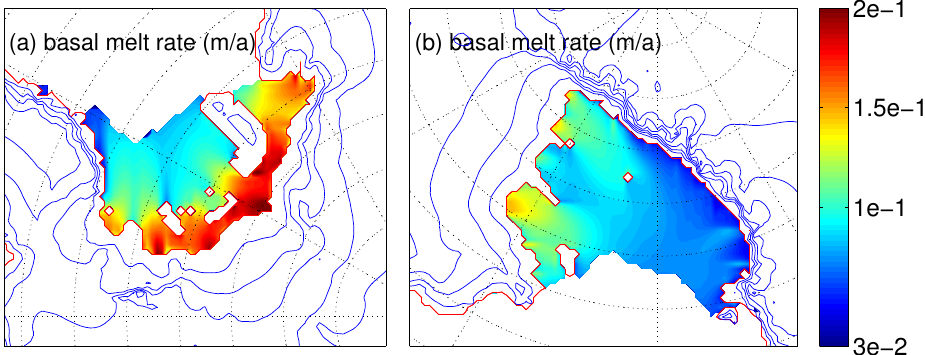
Fig. 1: Basal melt rate for (a) Ronne-Filchner and (b) Ross Ice Shelves, as given by Eq. (3). The parameterization used here leads to melt